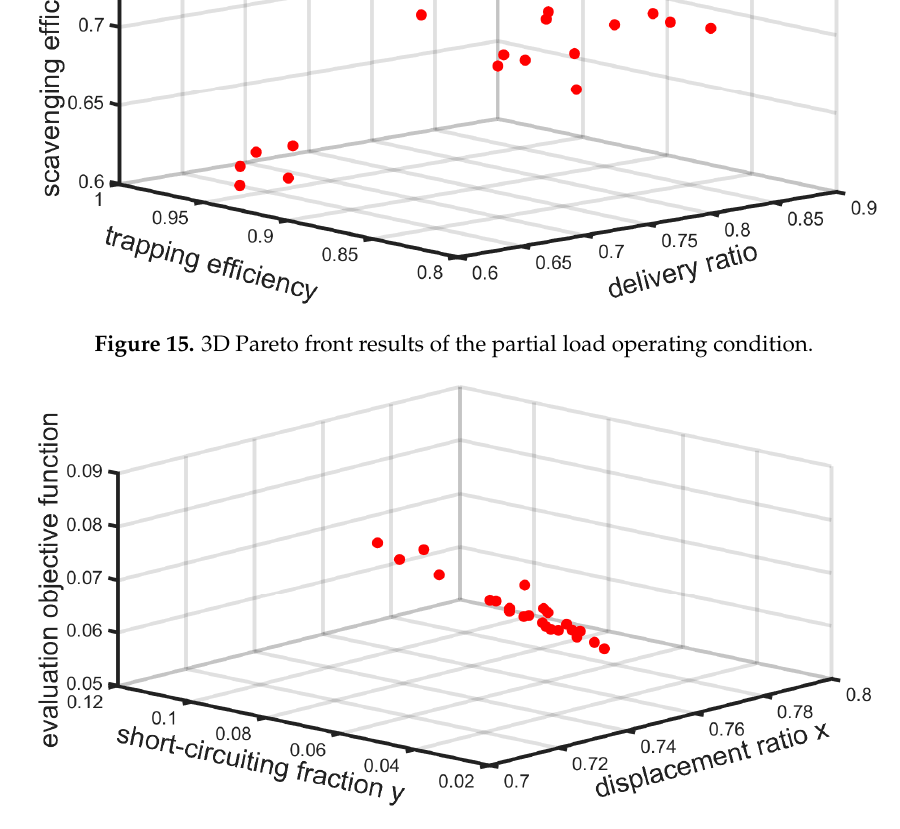
Figure 16. 3D Pareto front results of the high load operating condition.